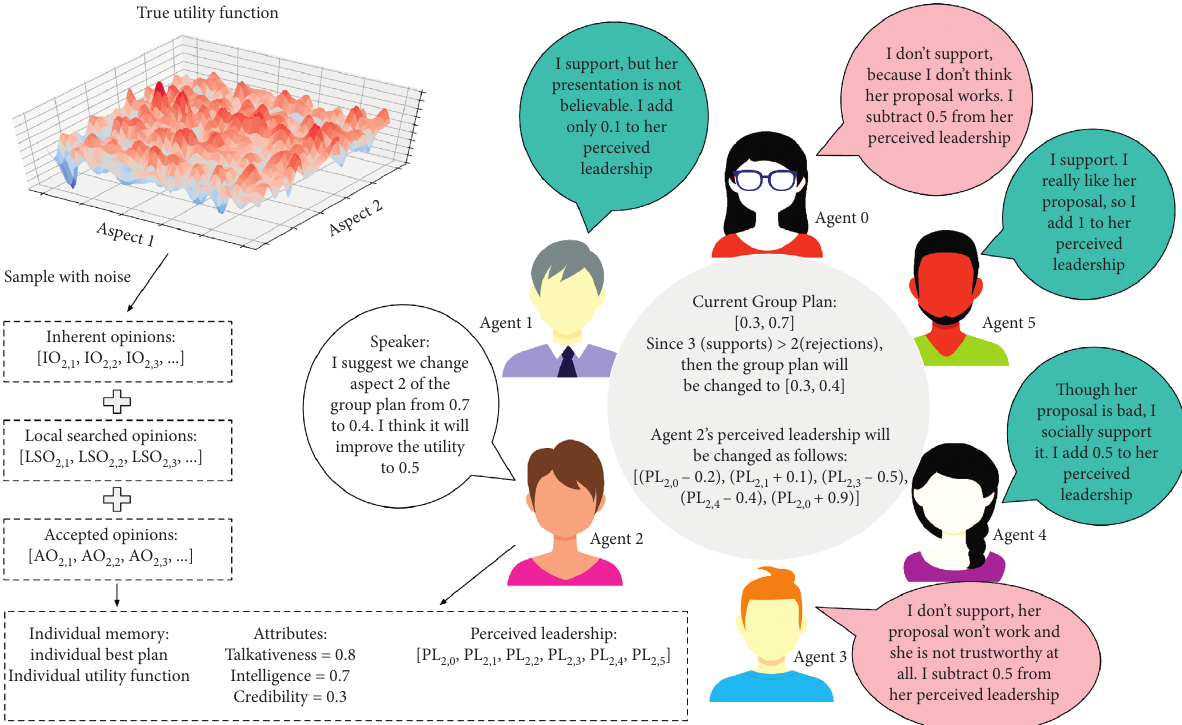
Figure 1: A schematic illustration of our agent-based model. A leaderless group consisting of n agents trying to find the maximum point of the true utility function displayed in the top-left corner, which is not directly accessible from any agent. Agents have limited knowledge about the true utility function. Prior to discussion, each agent initially samples a certain number of opinions from the true utility function as its inherent opinions, whose quantity and quality depend on its intelligence. Agents reconstruct models of the utility function as their individual utility functions from those memorized opinions. Meanwhile, each agent also picks one plan with highest utility in its memory as its current best plan. The individual utility function and the best plan will be updated as new opinions are added to memory. In the planning process, the group members either keep silent and think about the problem by themselves or discuss about the problem openly. When silent, each agent studies a new opinion around its best plan by itself, then updates its individual utility function. Also, it changes its best plan if the new opinion is better. The speaking process goes as follows. First, a speaker proposes a suggestion of modifying one aspect of the group plan. Second, other agents (listeners) evaluate the speaker’s perceived leadership according to the quality of its suggestion and the performance of its presentation. Finally, the listeners decide whether to adopt the speaker’s suggestion or not at individual and group levels. If the new plan is supported by more than half of the listeners, the group plan will be changed according to the speaker’s suggestion, otherwise the group plan remains unchanged. This cycle repeats for a certain number of